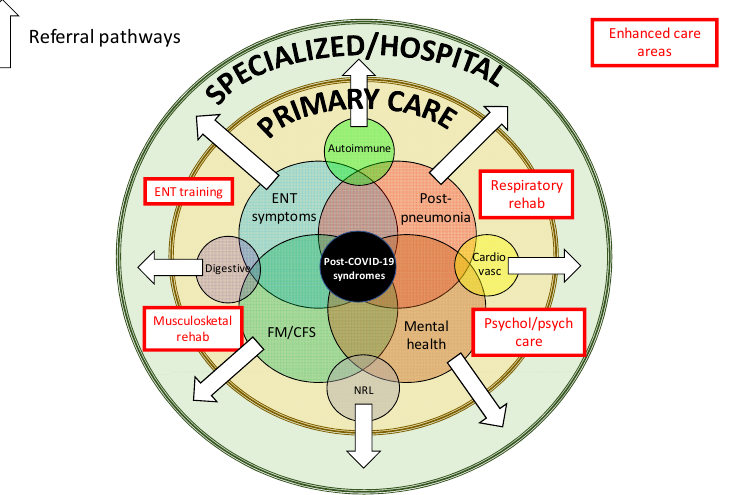
Figure 1. A graphic proposal for the multidisciplinary care of patients with long COVID-19 in primary care. Rehab: rehabilitation, ENT: Ear, Nose and Throat, FM: fibromyalgia, CFS: chronic fatigue syndrome, NRL: neurological, Cardiovasc: cardiovascular, Psychol/psych: psychological/psychiatric.